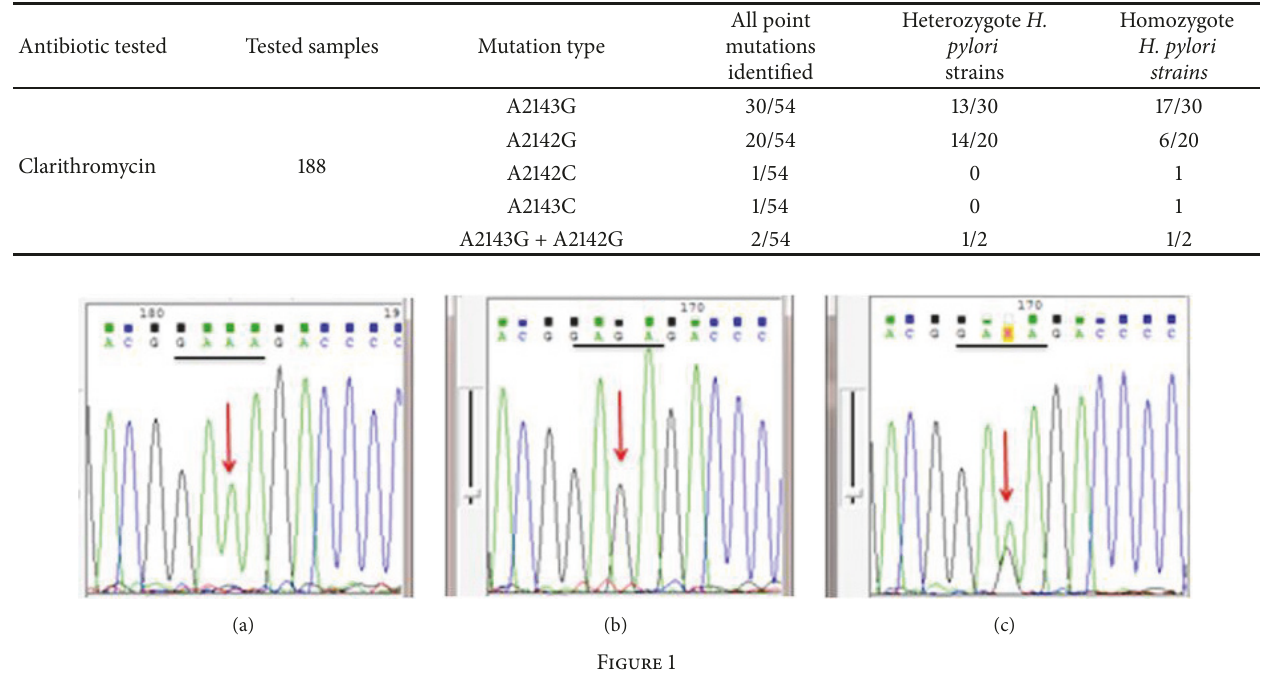
Table 2. Nine (11.7%) samples out of 77 had both wild